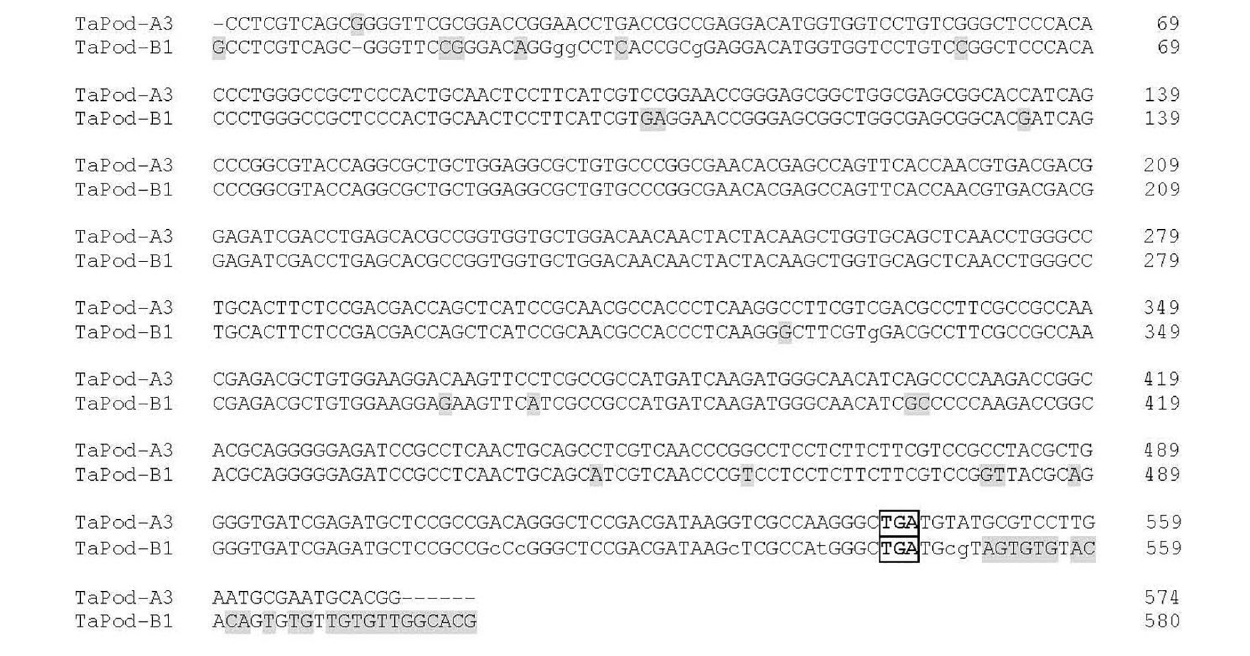
Frontiers in Plant Science |